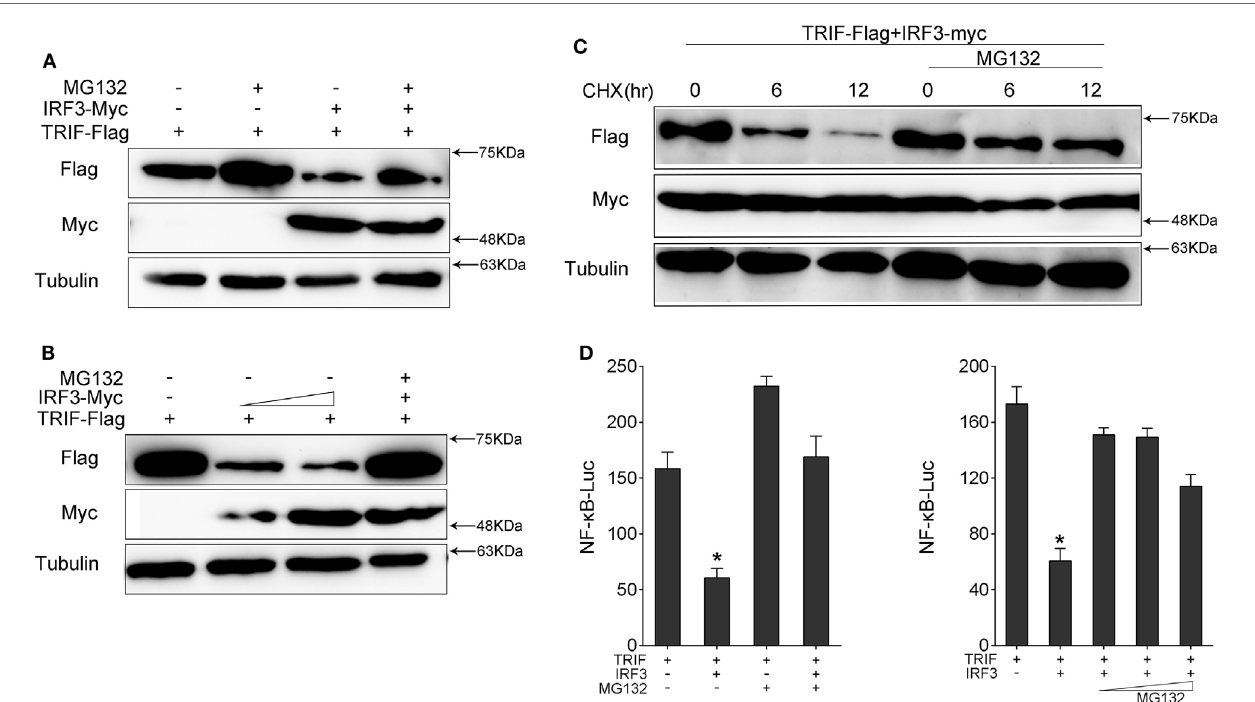
FigUre 7 | IRF3 induces TRIF degradation through proteasomal pathway. (a,B) HEK293 cells were co-transfected with TRIF and IRF3 or concentration gradient of IRF3 plasmids, after 36 h, the cells were treated with DMSO or 10 µM MG132 for 12 h before immunoblot analysis was performed. (c) HEK293 cells were transfected with TRIF and IRF3 plasmids, after 36 h, the cells were treated with cycloheximide (100 µg/ml), meanwhile the experiment group treated with DMSO or 10 µM MG132 for different times. TRIF protein levels were determined by immunoblot assays and normalized to tubulin. (D) HEK293 cells were co-transfected with TRIF, IRF3, together with NF- κ B reporter gene, after 36 h, the cells were treated with DMSO or 10 µM MG132 or concentration gradient MG132 (5, 10, and 15 µM) for 12 h, then the luciferase activity was measured. The luciferase activity value was achieved against the Renilla luciferase activity. * p < 0.05 versus the